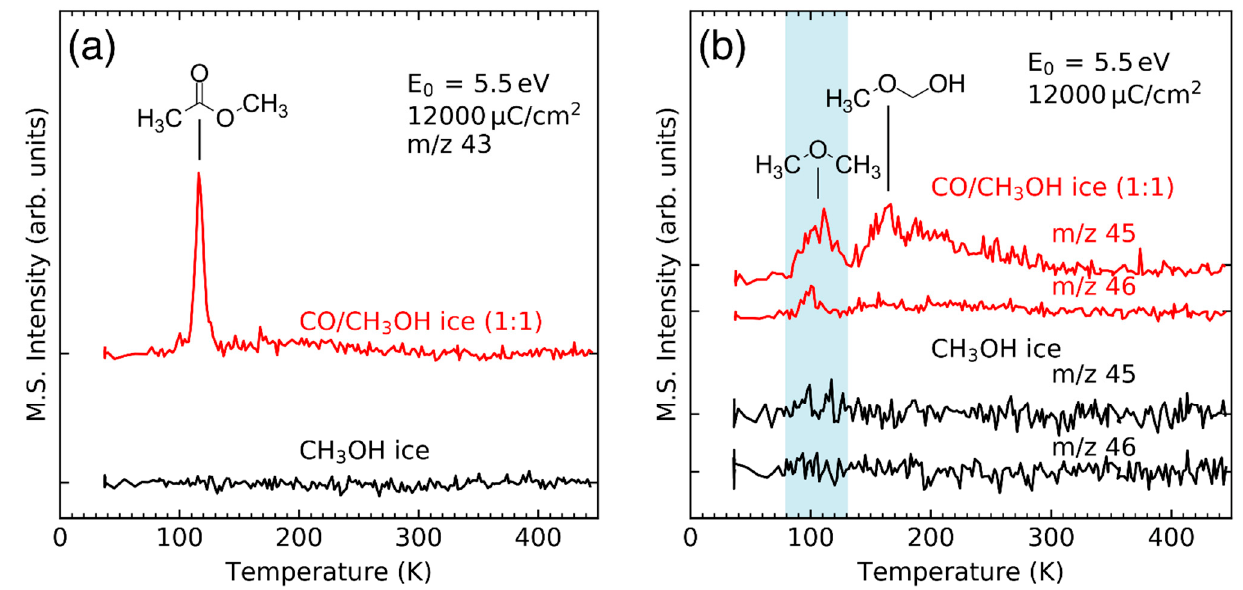
Figure 21. Thermal desorption spectra obtained after irradiation of CO/CH 3 OH (1:1) mixed ices and of pure CH 3 OH with 12,000 µ C/cm 2 at 5.5 eV. Panel ( a ) shows the formation of methylacetate in the mixed films but not in pure CH 3 OH. Panel ( b ) shows the formation of dimethylether (shaded in blue in the mixed ices but not in pure CH 3 OH. The second desorption signal in the m / z 45 trace at around 170 K is a fragment of methoxymethanol. Adapted from Ref. [26] with permission from the PCCP Owner Societies.